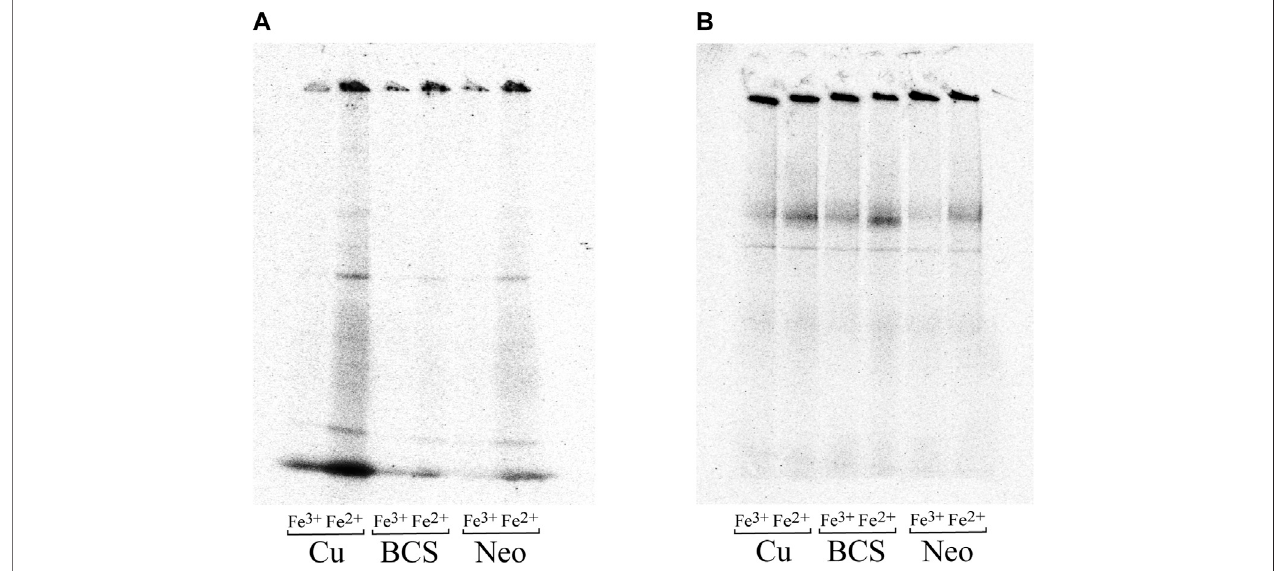
FIGURE5| Ironuptakeisregulatedbycopperin N.gruberi butnotin N.fowleri. Ferrousandferricironuptakeby N.gruberi (A) and N.fowleri (B) undercopper-rich and copper-de fi cient conditions. Autoradiography of blue native electrophoresis gels of whole-cell lysates of N. gruberi and N. fowleri cells incubated with 25 µM BCS (BCS), 5 µM neocuproine (Neo), and 25 µM Cu 2 SO 4 (Cu) for 72 h and further incubated with 55 Fe(II) (ferrous ascorbate) or 55 Fe(III) (ferric citrate) for 1 h.